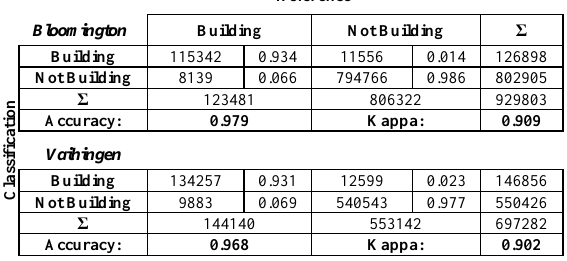
Table 1. Confusion matrix presenting the TP, FP, TN, and FN number of points, TPR (sensitivity/recall), TNR (specificity), FPR, FNR, accuracy, and Kappa values for the Bloomington (top) and Vaihingen (bottom) building extraction results.